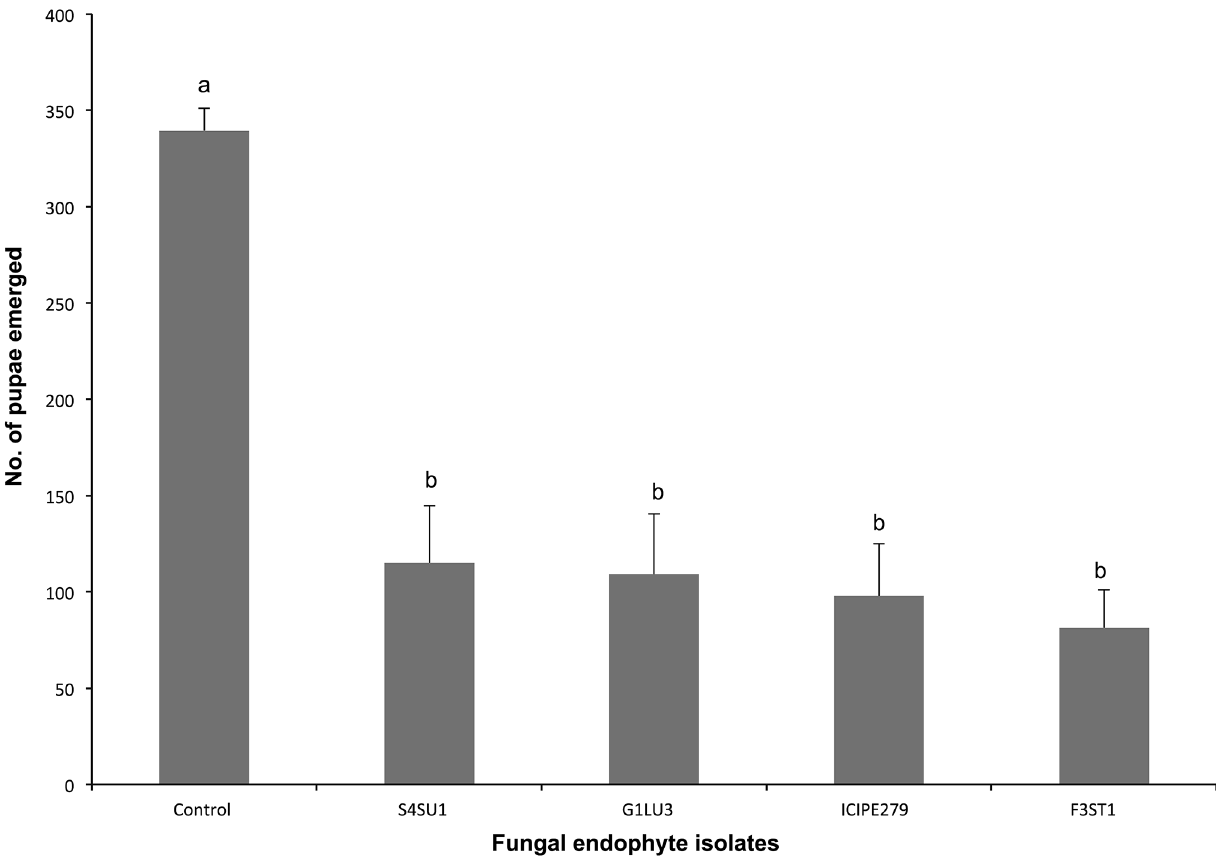
Figure 5. Effect of Viciafaba plants endophytically-colonized by different fungal isolates of Beauveriabassiana (S4SU1, G1LU3 and ICIPE 279) and Hypocrealixii (F3ST1) on adult emergence of Liriomyzahuidobrensis and Diglyphusisaea . Bars denote means 6 one standard error at 95% CI (p=0.05).